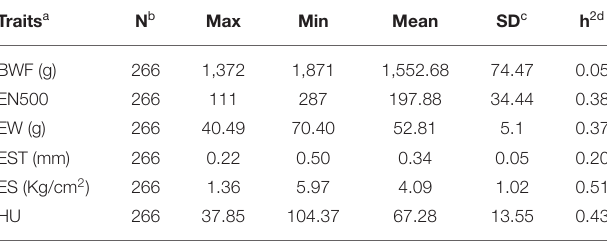
TABLE 1 | Descriptive statistics for production and egg quality traits.